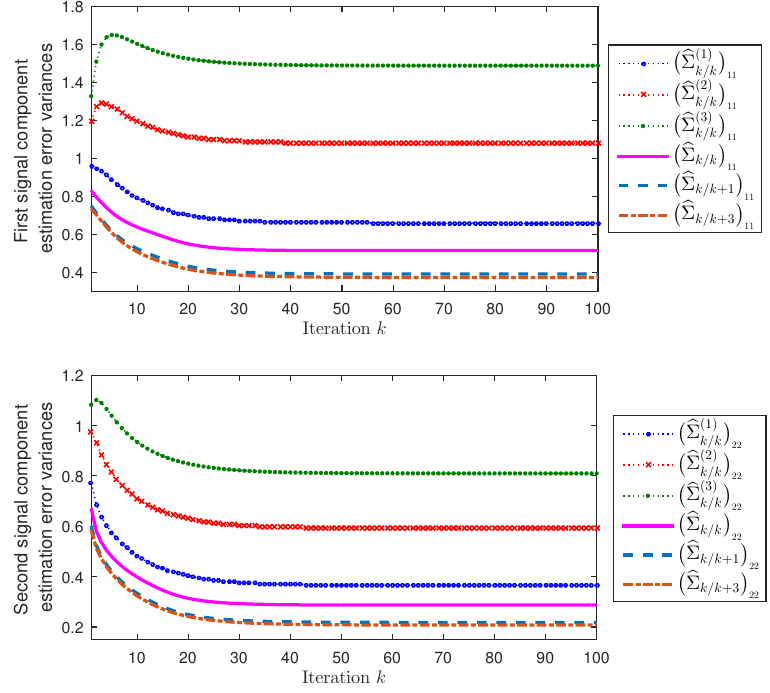
Figure 2. Local filtering and distributed filtering and fixed-point smoothing error variances of the first and second signal